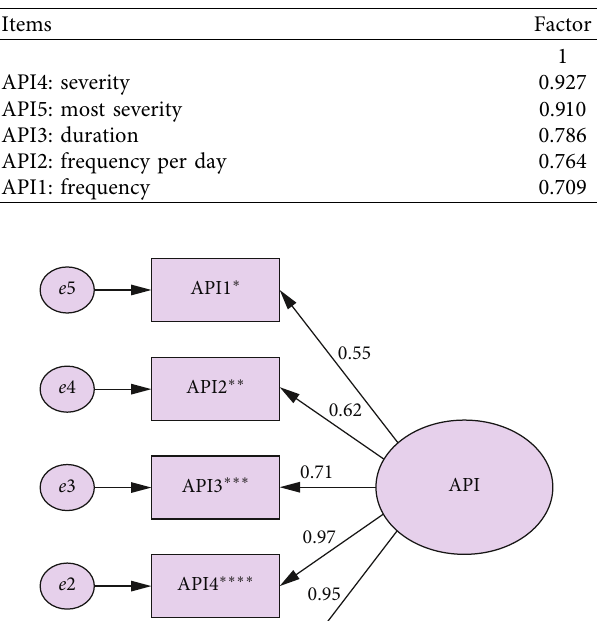
Table 2: Principal component analysis and factor loadings for five API